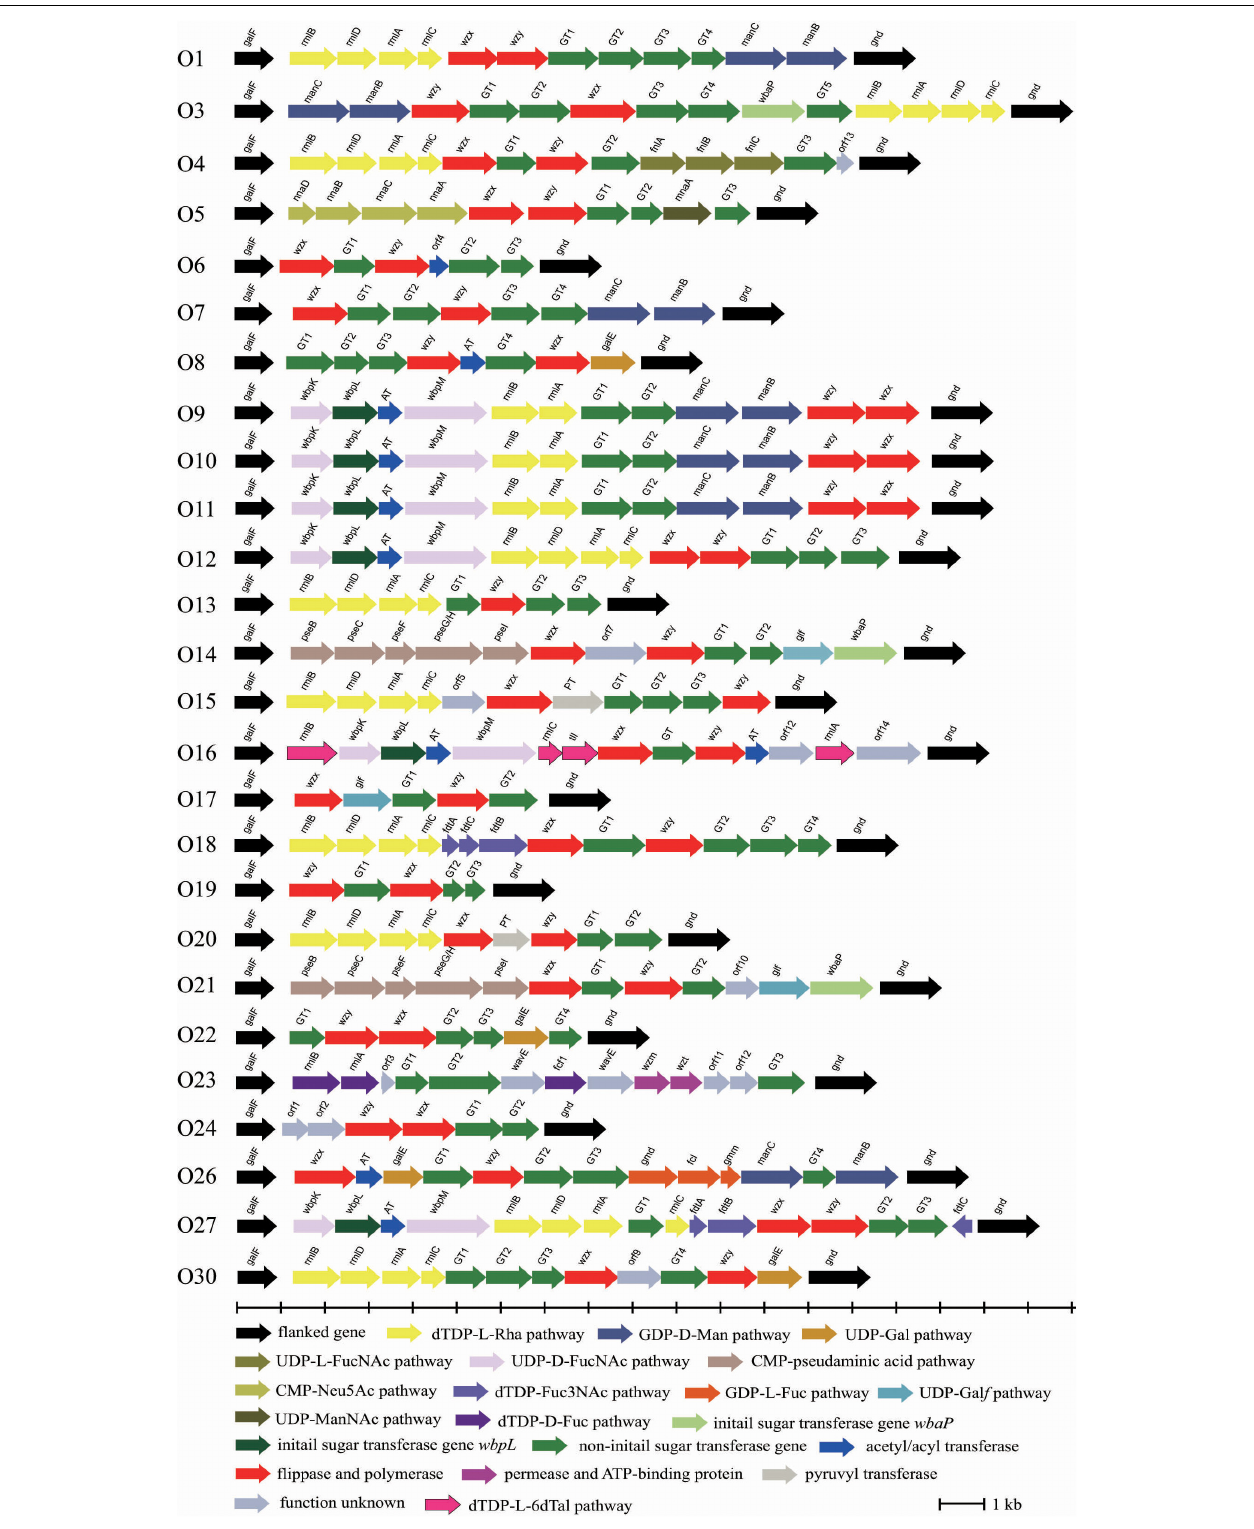
FIGURE 1 | Schematic diagram of the O-AGCs identified from the 26 E. cloacae reference strains. Genes are represented by arrows and colored according to the gene key at the bottom with gene names indicated above each arrow.